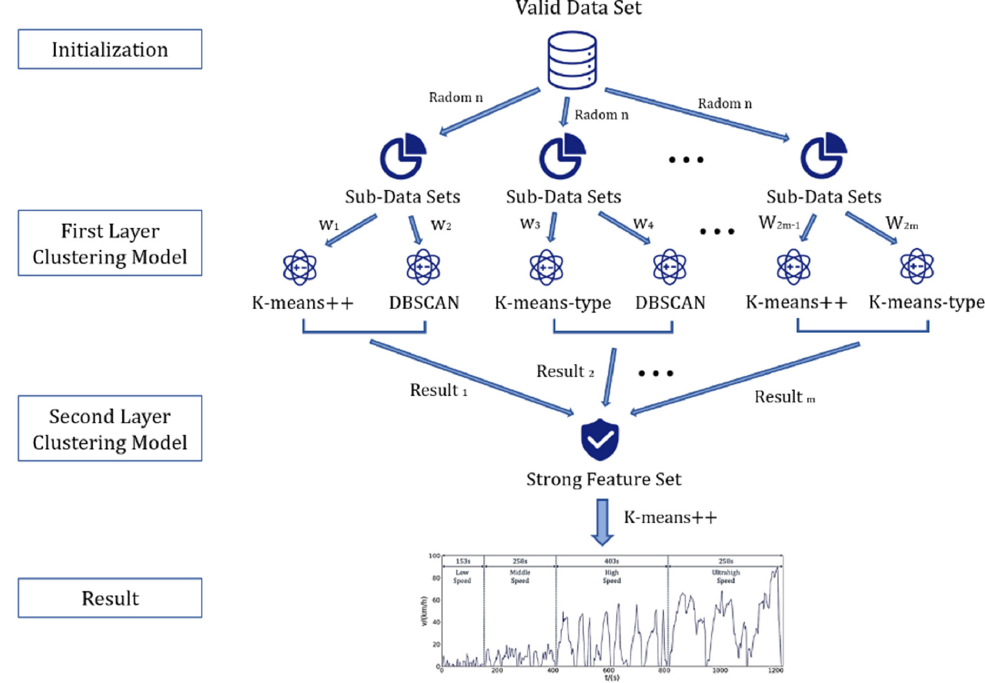
Figure 3. The multi-clustering algorithm framework diagram.